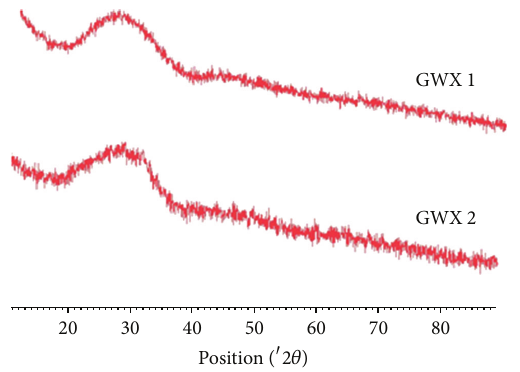
Figure1:XRDpatternsforGWX1(analyticalgradeSiO 2 )andGWX 2 (SLS waste glass).